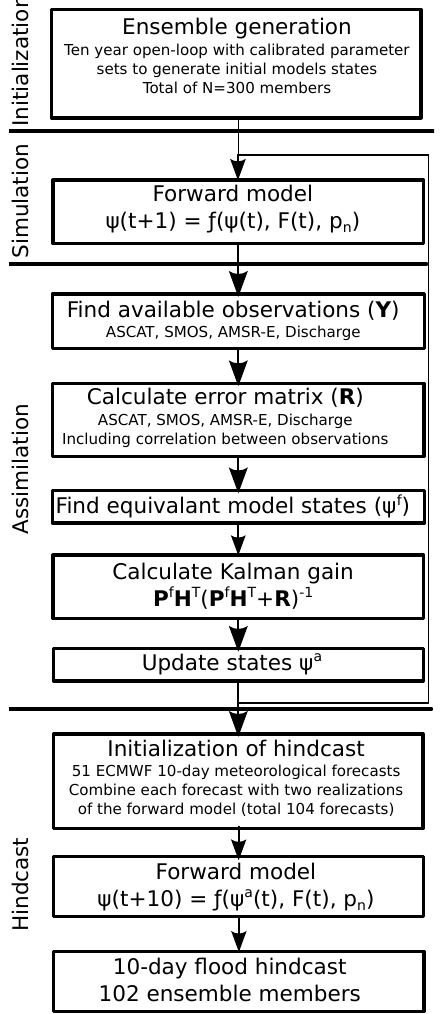
Figure 3. Flowchart of the hindcasting procedure including ini- tialization of the model and the construction of the reanalysis time